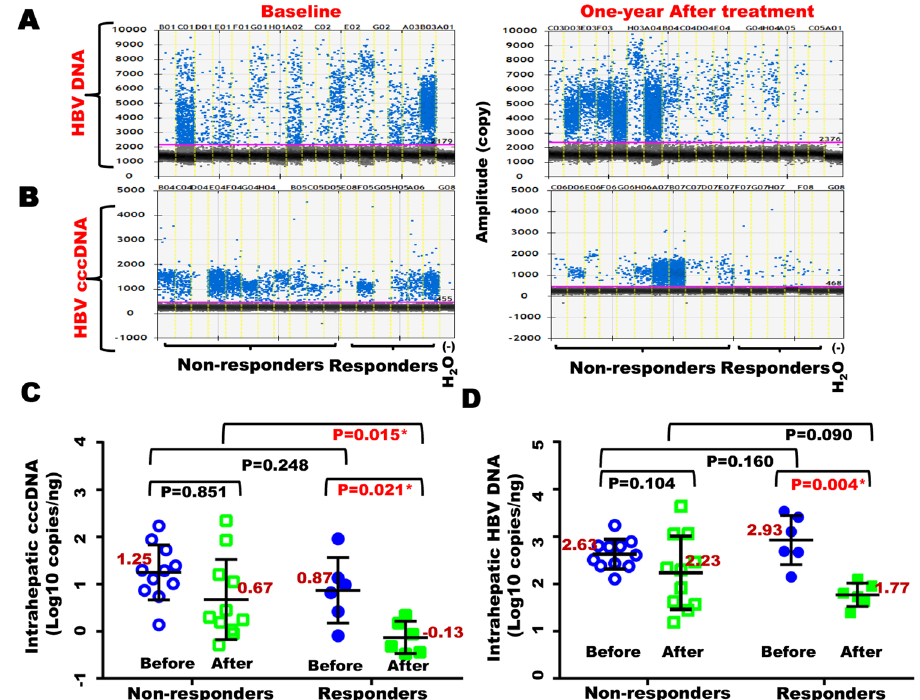
Figure 2. Amplification of HBV cccDNA and HBV DNA by ddPCR in paired liver biopsy specimens from 17 CHB patients at baseline and one-year after treatment with PEG-IFN. ( A ) Amplification of HBV DNA and cccDNA ( B ) by ddPCR system from liver biopsies obtained from CHB patients before and after treatment with PEG-IFN. ( C ) Quantification of intrahepatic HBV cccDNA and HBV DNA ( D ) before and after IFN treatment in responders and non-responders. Before, before treatment; After, after